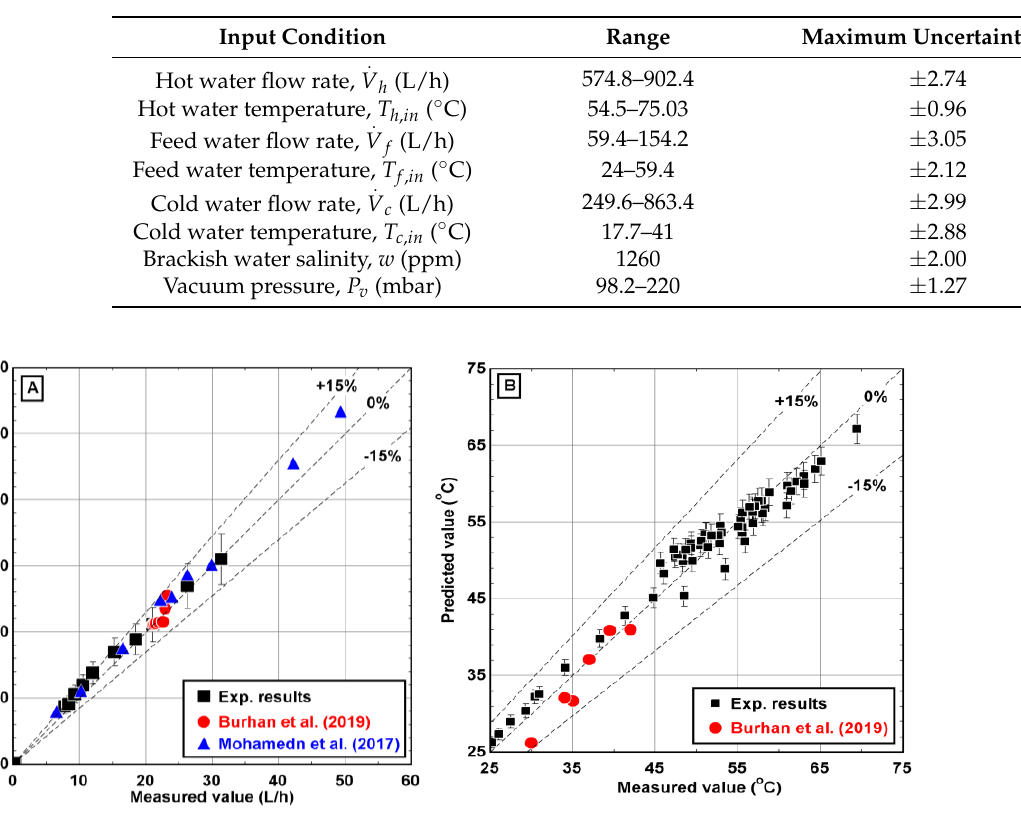
Table 4. Range of operating conditions for the experimental trials.